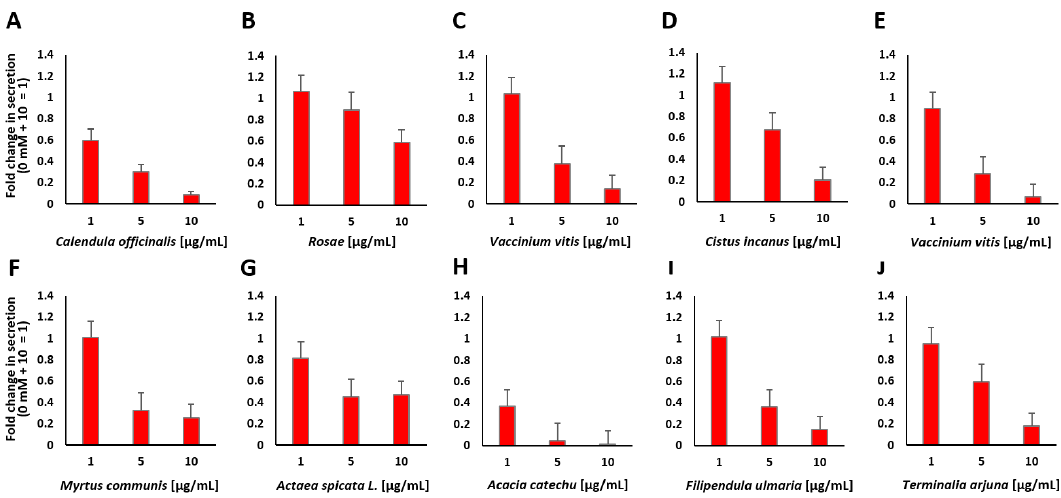
Figure 5. Insulin secretion from MIN6 β cells in response to stimulation with 10 mM glucose after preincubation with various concentrations of the indicated plant extracts ( A – J ). Fold change in the amount of secreted insulin expressed as luciferase activity from Ins-GLuc normalized to the activity of 0 mM + 10 mM glucose expressed as fold change ± SEM ( n ≥ 11).